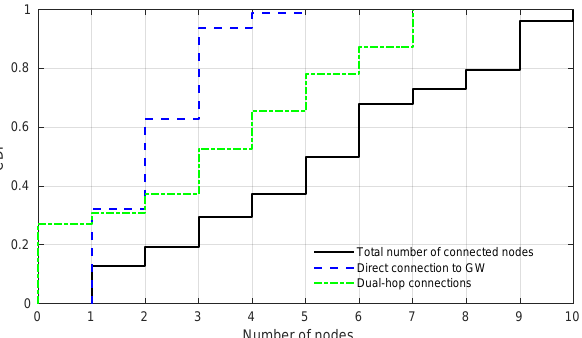
Figure 24. Overall connectivity statistics from the North Sea Deployment show that many nodes failed to find any links to the gateway, single-hop or dual-hop.